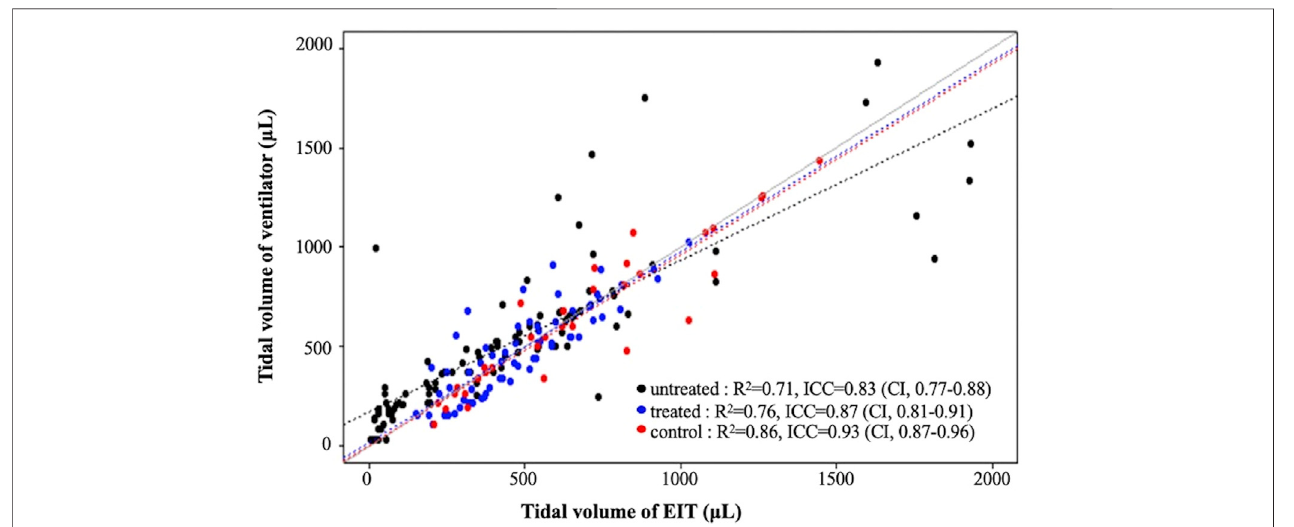
FIGURE 3 | Linear regression analysis and intraclass correlation coef fi cient (ICC) of tidal volumes determined by the ventilator and EIT V T in each group.